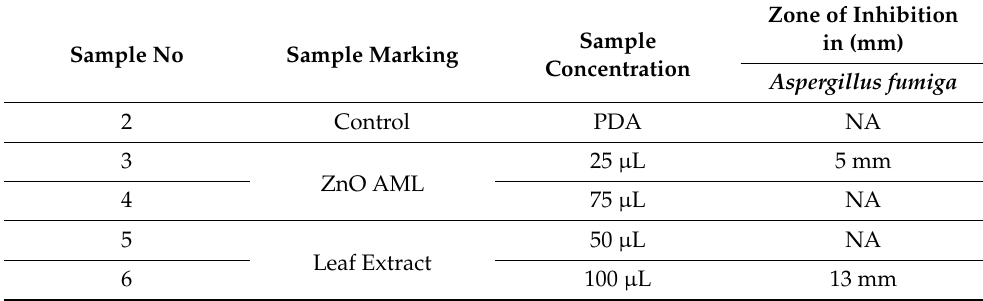
Table 5. Antifungal activity of ZnO nanoparticles.